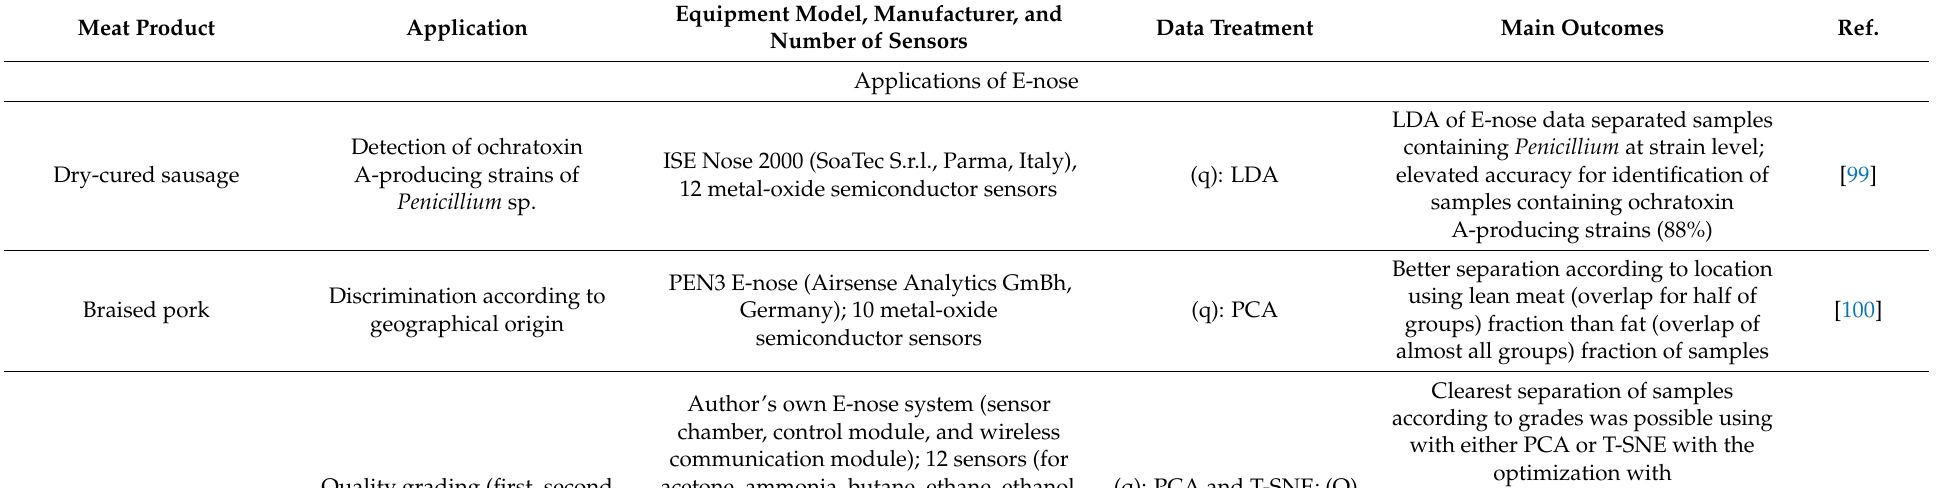
Table 2. Application of E-nose, E-eye, and E-tongue in processed meat and meat